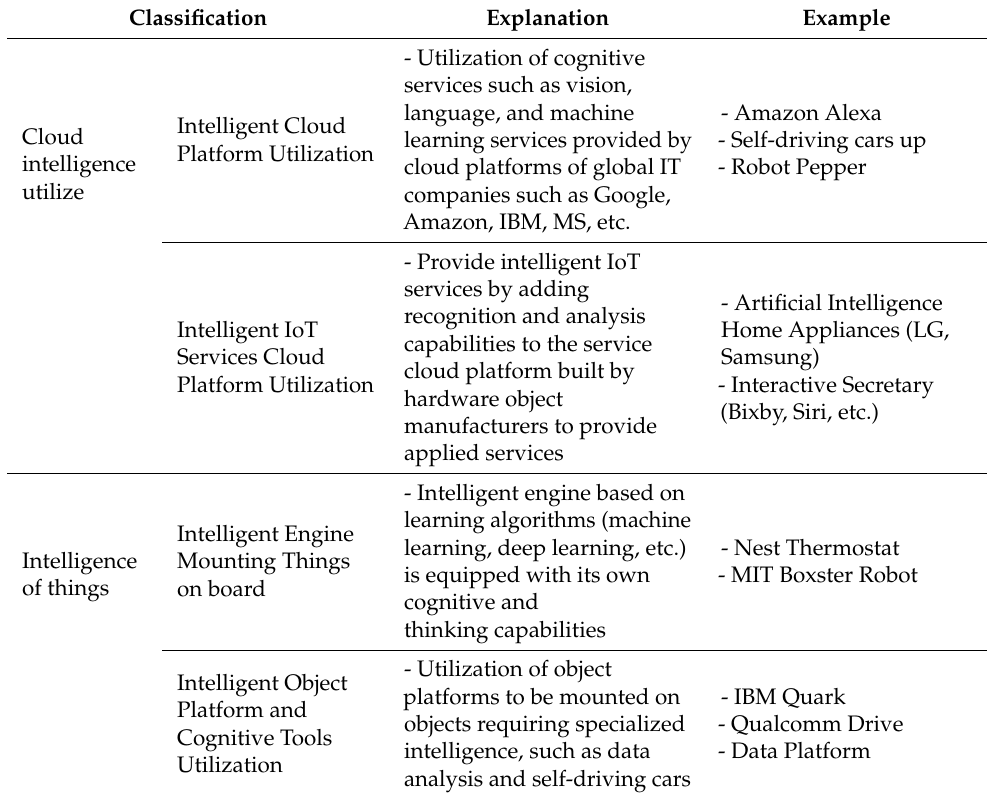
Table 1. Classification of AIoT Implementation